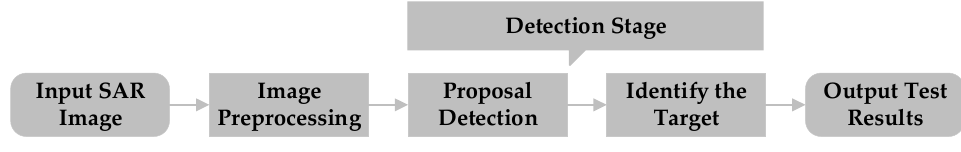
Figure 1. The flow diagram of SAR image target detection.